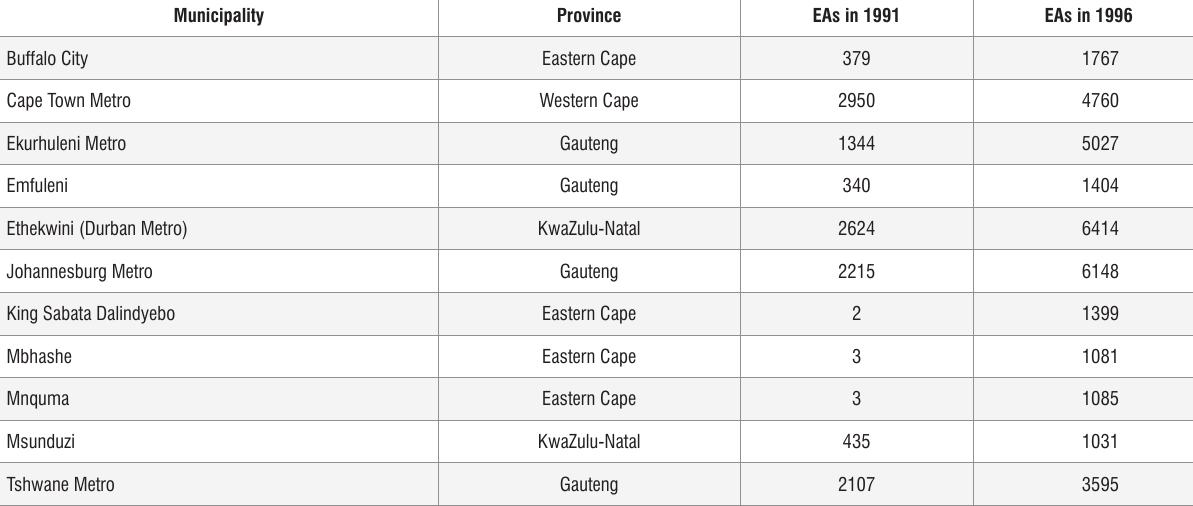
Table 2: Number of enumeration areas (EAs) in municipalities with more than 1000 EAs